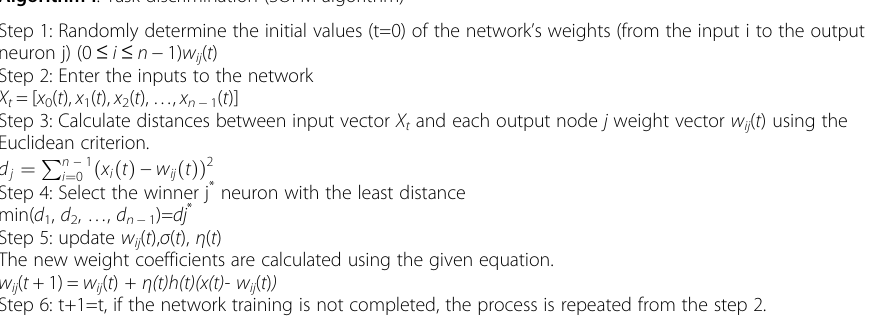
Algorithm-I : Task discrimination (SOFM